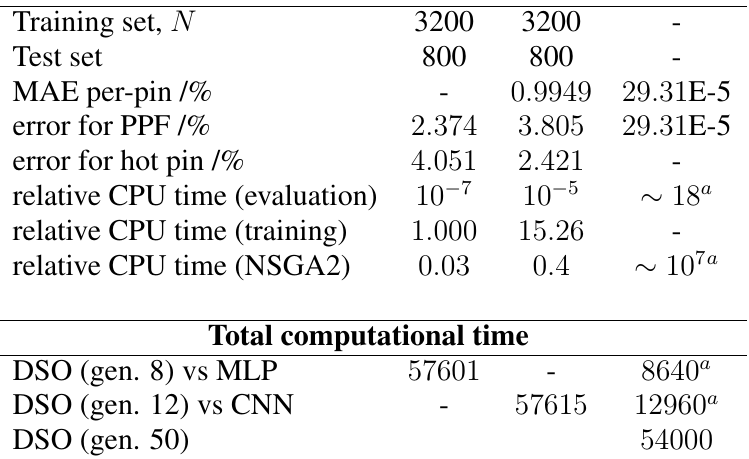
Figure 4: Pareto fronts for DSO solutions and SMO (MLP and CNN) solutions; the SMO solutions have been re-evaluated using Serpent (N=3200, graph results 7.py ) Table 2: MAE for MLP, CNN and Monte Carlo on training data (mean values for 30 runs) MLP